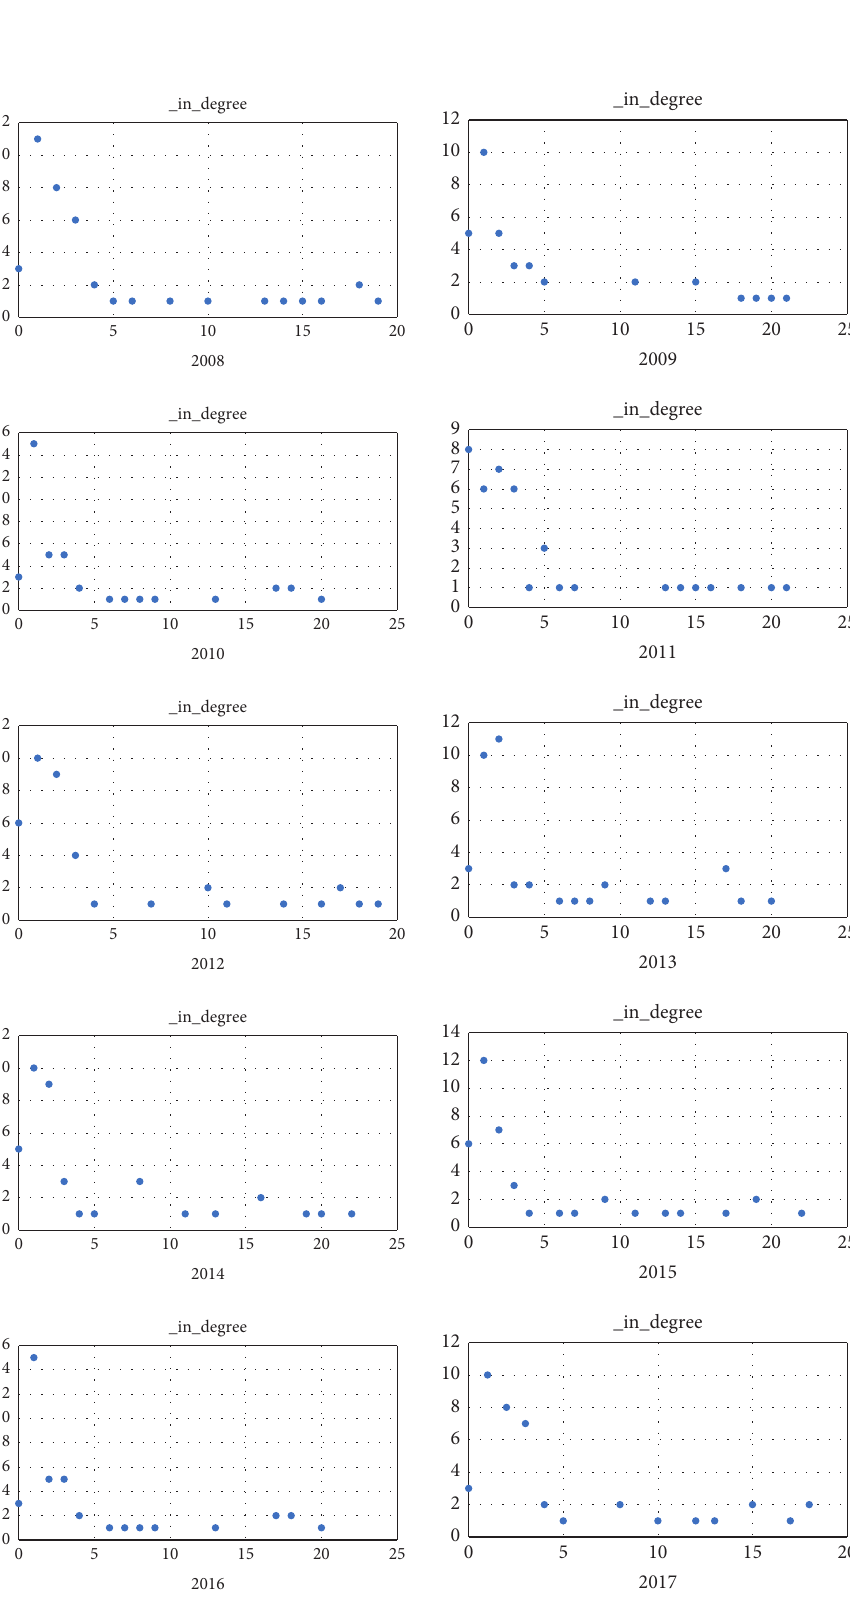
Figure 3: In-degree indicator of the Asian crude oil market network. Source: results calculated from the software STATA